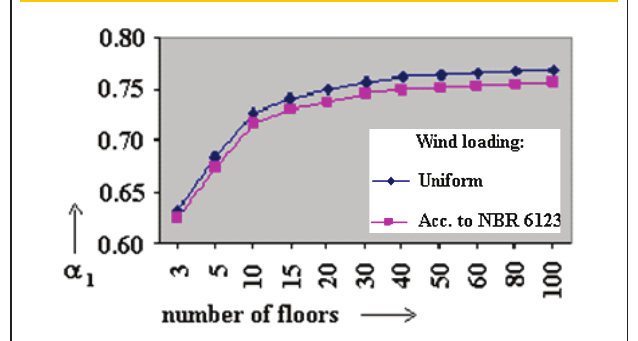
Figure 7 – Values of a 1 obtained in the